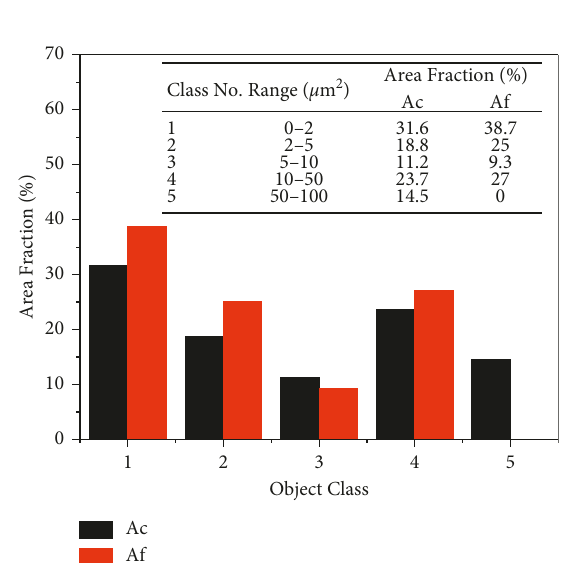
Figure 4: Comparison of area fraction of the SRBSN fabricated by the postsintering of RBSN.